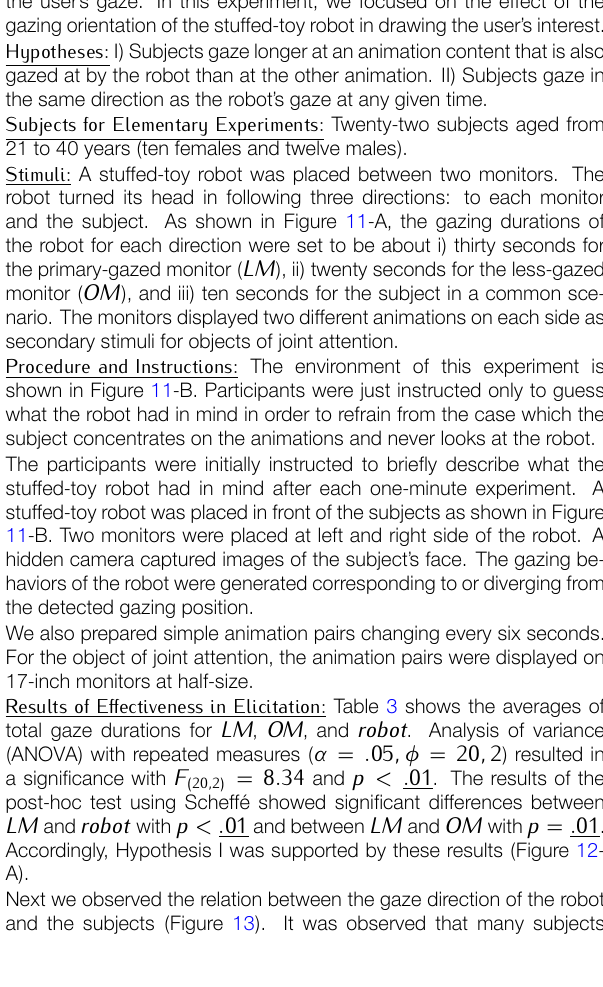
Figure 12. Observation of User’s